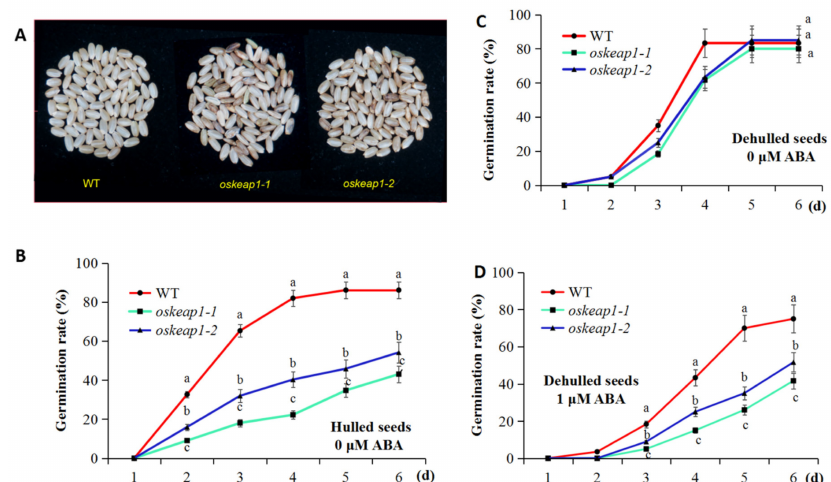
Figure 7. The phenotype of dehulled rice grains of wild-type Xidao#1 (WT) and its oskeap1 mutants ( A ) and germination rate of hulled seeds ( B ) and dehulled seeds (brown rice) on medium without ( C ) or with ( D ) 1 µ M abscisic acid (ABA). Data from the same observation date with di ff erent letters (a,b,c) are significantly di ff erent at the 0.05 level.